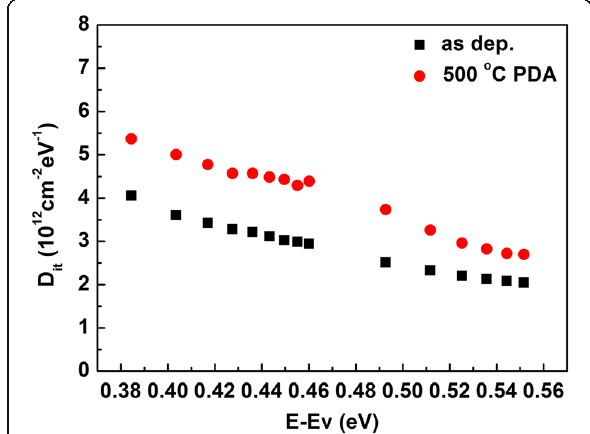
Fig. 3 Distribution of D it below E c in the band gap at room temperature for Pt/HfO